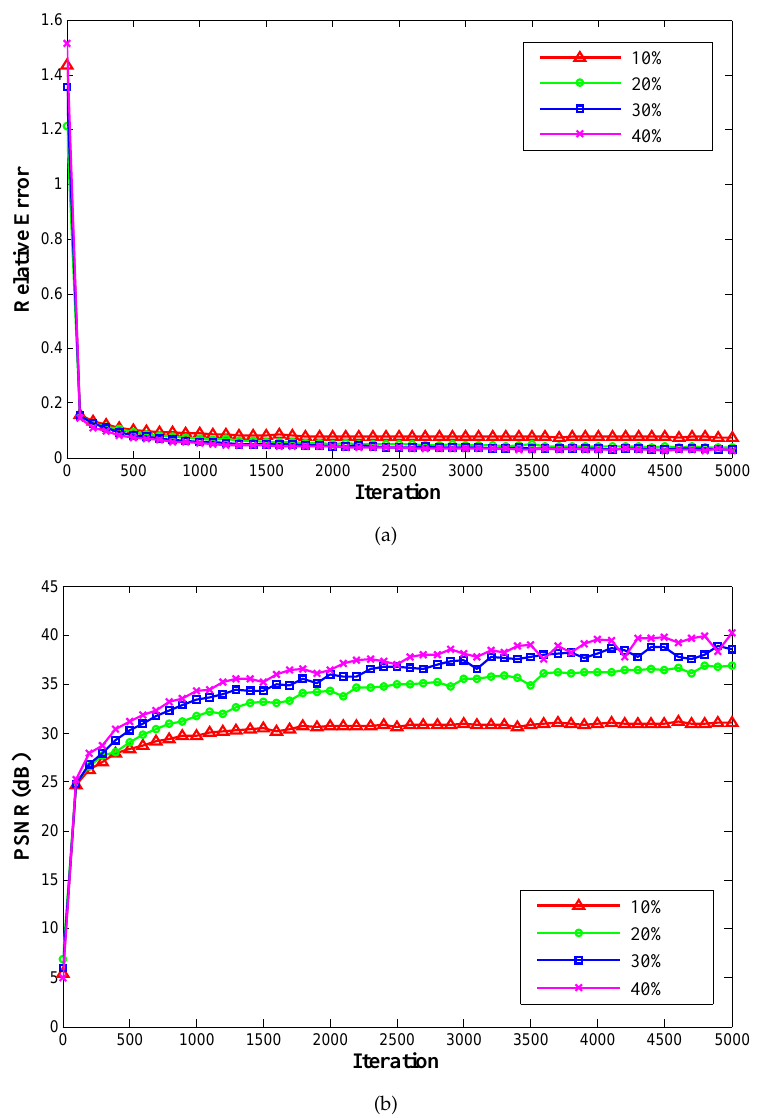
Figure 8. Results of the convergence for the proposed method at different sampling rates under the Cartesian undersampled mask: relative error curves ( a ) and PSNR curves ( b